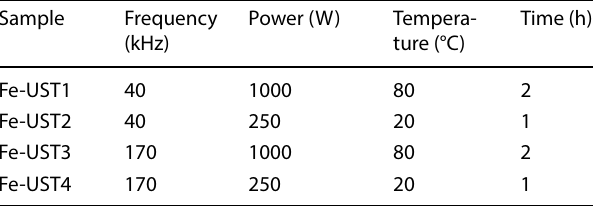
Table 1 Ultrasonic pre-treatment conditions applied to wood chips